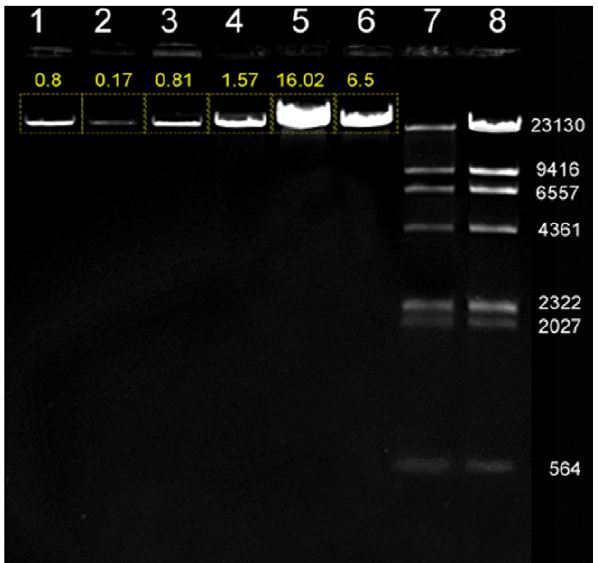
Figure 4. Isolation of lambda phage DNA using NID-based extraction. The DNA samples loaded in lanes 1–5 were generated varying only the composition of the phage particle extraction buffer. The particles were precipitated and the lambda DNA was extracted from all samples using the same procedure as described in Materials and Methods. Lane 1: bacteria were incubated in the isotonic component of the lambda NID extraction buffer, i.e. 5% sucrose and 50 mM Tris pH 8. 10 m l DNA were loaded in the gel. Note minimal leakage of phage particles in this lane. Lane 2: the same buffer as lane 1 was used, but with the addition of 50 mM CaCl 2 . 10 m l DNA were loaded. Note partial suppression of phage particles leakage. In lanes 3 and 4, all components of the lambda NID extraction buffer were added except lysozyme and Tween 80, respectively. 3 m l DNA were loaded. Lane 5: bacteria were incubated with the complete lambda NID extraction buffer, and 2 m l DNA were loaded. Lane 6: cells were lysed with chloroform (full lysis sample), and 0.5 m l DNA were loaded on the gel. Lanes 7 and 8: Hind III was used to digest the samples loaded in lanes 5 and 6, respectively. Densitometry analysis of the bands in lanes 1–6 is reported.